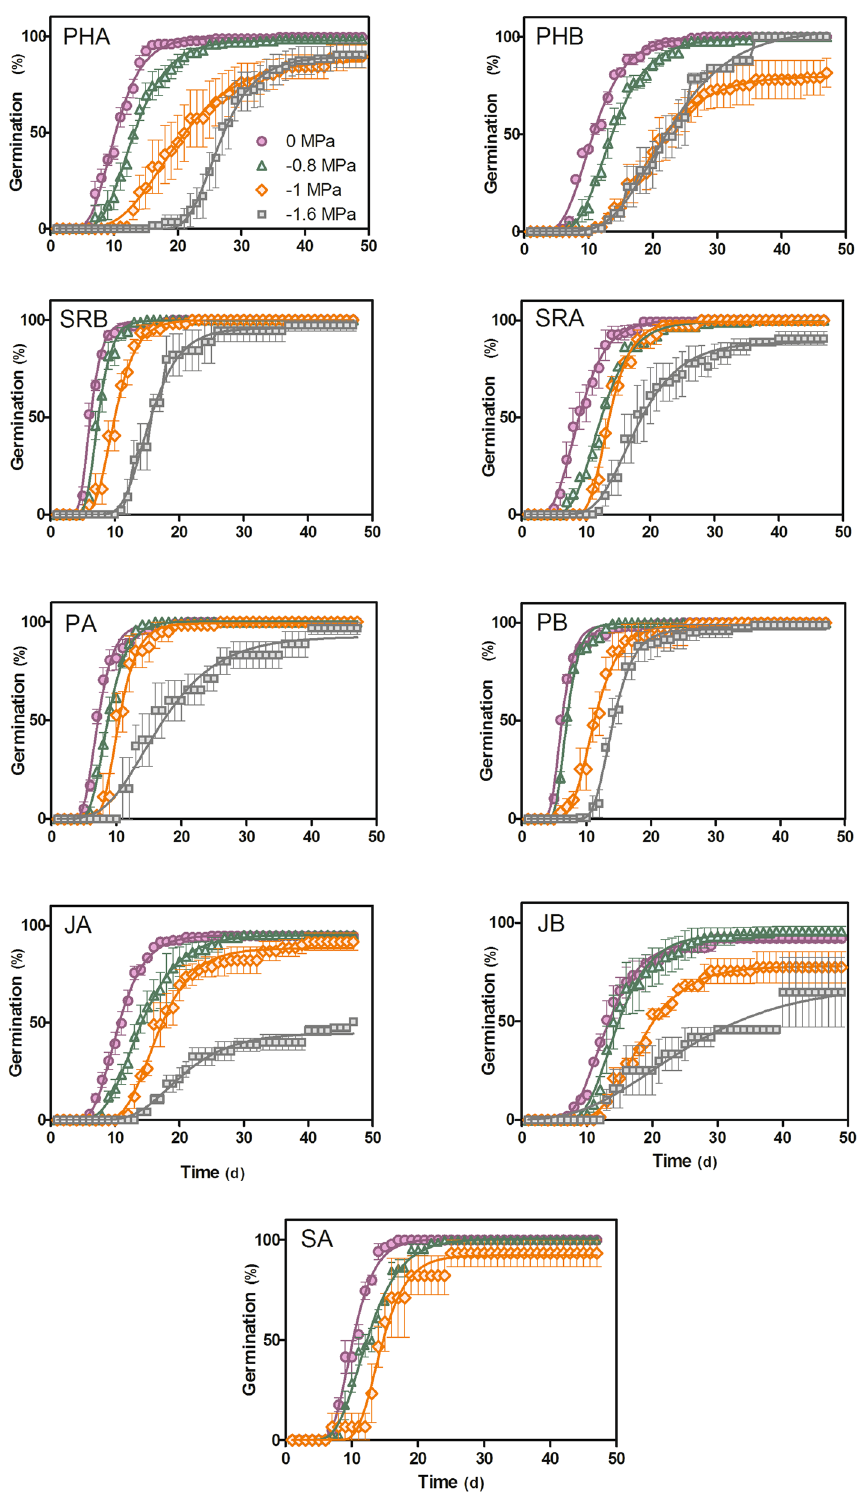
Figure 1. Cumulative germination curves for the nine populations of Festuca pallescens . The germination time-course curves at 0, − 0.8, − 1 and − 1.6 MPa were calculated with non-linear adjustment to the Gompertz equation. The SA population did not germinate at − 1.6 MPa (i, r). The vertical bars represent the standard error of the mean (SEM). The coloured symbols correspond to the working water potentials: Violet circle (0 MPa), green triangle (− 0.8 MPa), orange square (− 1 MPa) and grey square (− 1.6